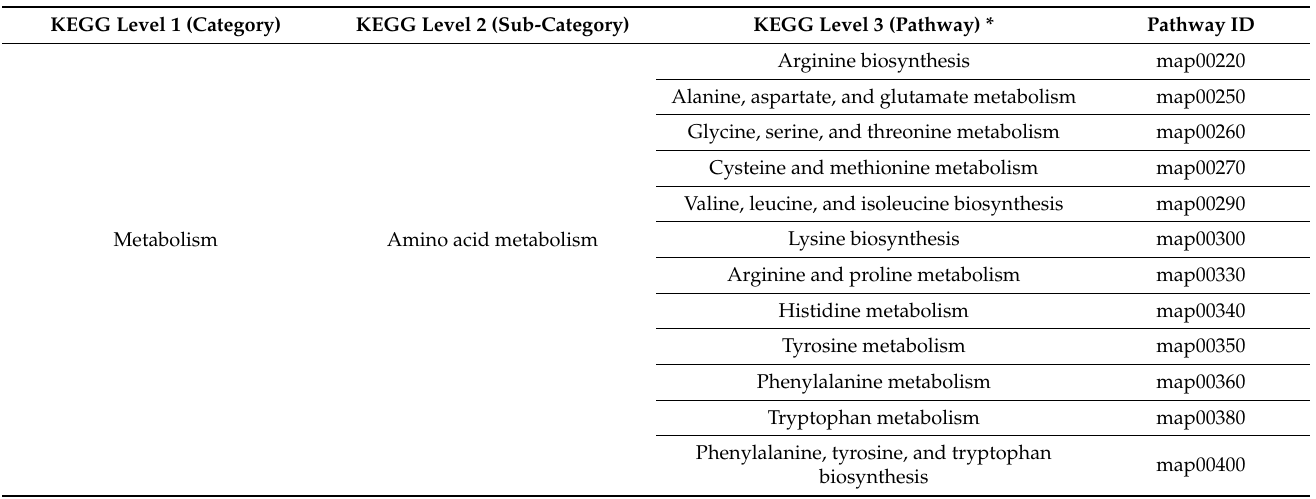
Figure 2. Abundance of genes encoding enzymes of the different functional categories of KO database Level 1 across ( a ) and between ( b ) samples of rhizosphere (R) and surrounding bulk soil (S) microbiomes of M. oleifera. Columns with dark colors in ( b ) refer to rhizosphere (R) soil microbiome, while those with light colors refer to microbiome of the surrounding bulk (S) soil. The “others” column refers to genes encoding proteins or enzymes not functioning in KEGG pathways. The data in ( a ) and ( b ) are further described in Figures S1 and S2, respectively, while detailed abundance records are shown in Tables S5 and S8, respectively. Same column color in ( a ) and ( b ) represents same KEGG category. Table 1. Description of some enriched pathways across rhizosphere and bulk soil microbiomes of M. oleifera at the KEGG database Levels 1, 2, and 3 along with pathway